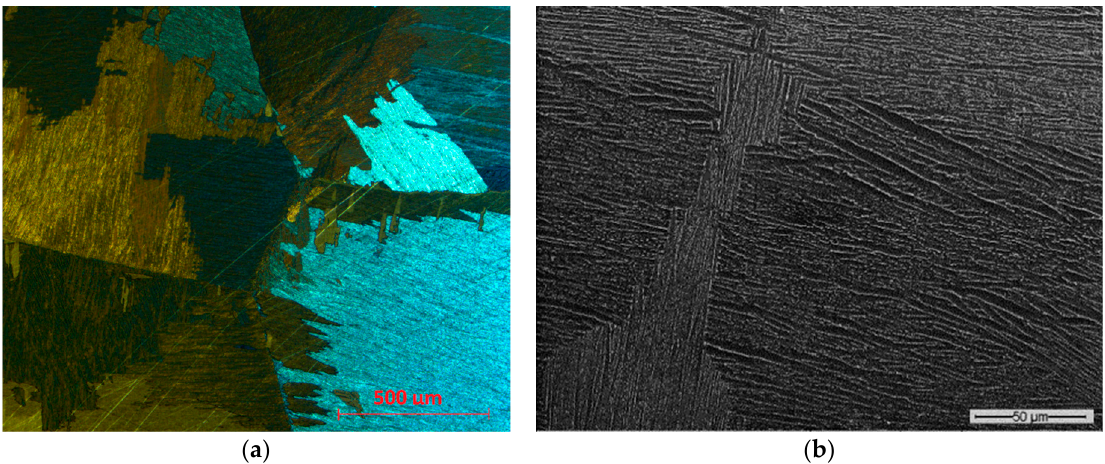
Figure 5. Lamellar microstructure obtained with annealing temperature T β + 25 °C for 1 h 30 min, viewed with polarized optical microscopy ( a ) and SEM ( b ).